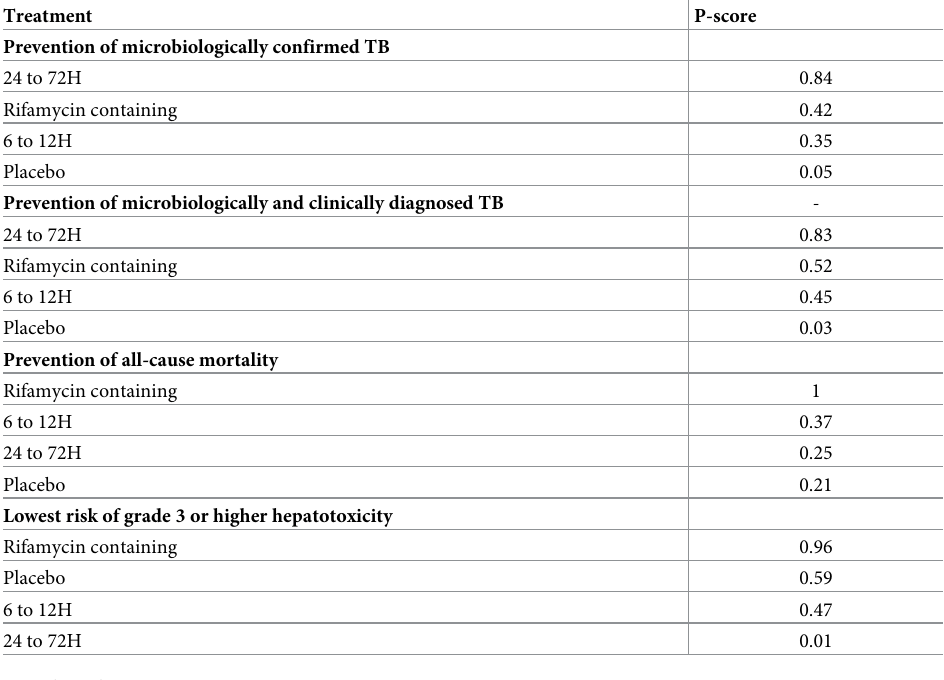
Table 7. Ranking of regimens for each outcome evaluated.